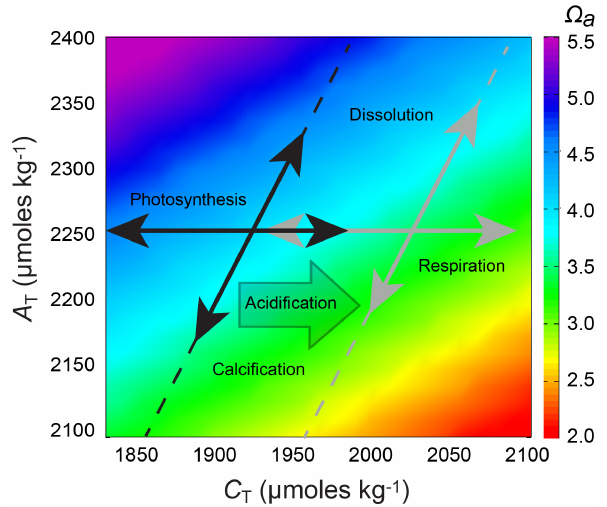
Fig. 1. Biogeochemical drivers of reef water carbon chemistry and effects of ocean acidification on aragonite saturation state ( (cid:127) a ). Cal- cification and dissolution affect total alkalinity ( A T ) as well as the concentration of dissolved inorganic carbon ( C T ), whereas photo- synthesis and respiration affect C T only. (cid:127) a changes linearly with A T and C T and can thus be expressed directly as a compound function of carbon fluxes (Eq. 5). Vectors indicate the directions and relative strengths of the benthic biological/biogeochemical pro- cesses under a present-day (solid) and acidified (dashed) scenario. Absolute vector lengths are hypothetical, but will vary with water depth, residence time, and the abundances and composition of pri- mary producers and calcifiers. The projection was run for tempera- ture=27 ◦ C and salinity=35. Modified from Anthony et al.